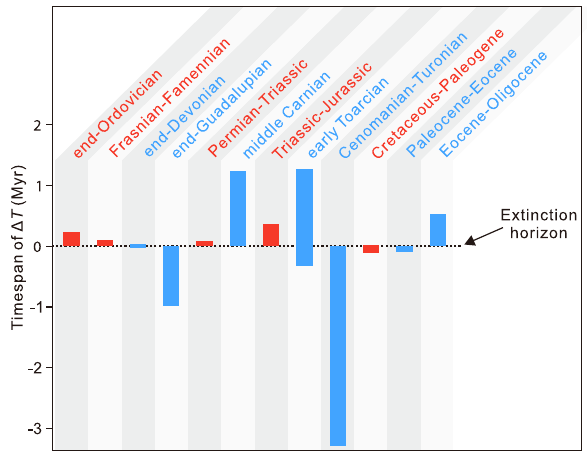
Fig. 4 Timing of temperature change ( Δ T ) relative to extinction horizon for the major (red) and minor (blue) extinctions during the past 450 million years. The dashed line is the position of the extinction horizon in relation to the time span of the largest magnitude climate changes (colored bars) within the time interval containing the extinction. The exception to this is the end-Devonian bar (see Supplementary Fig. 3). This bar represents instead the timespan of glaciation in the latest Devonian. The plot emphasizes how the timing of extinction is contemporaneous with large magnitude climate change (within the resolution of the available data). For the ages of mass extinctions and Δ T see Supplementary Table 3. Red and blue bars represent Big Five and minor mass extinctions, respectively. Source data are provided as a Source Data fi